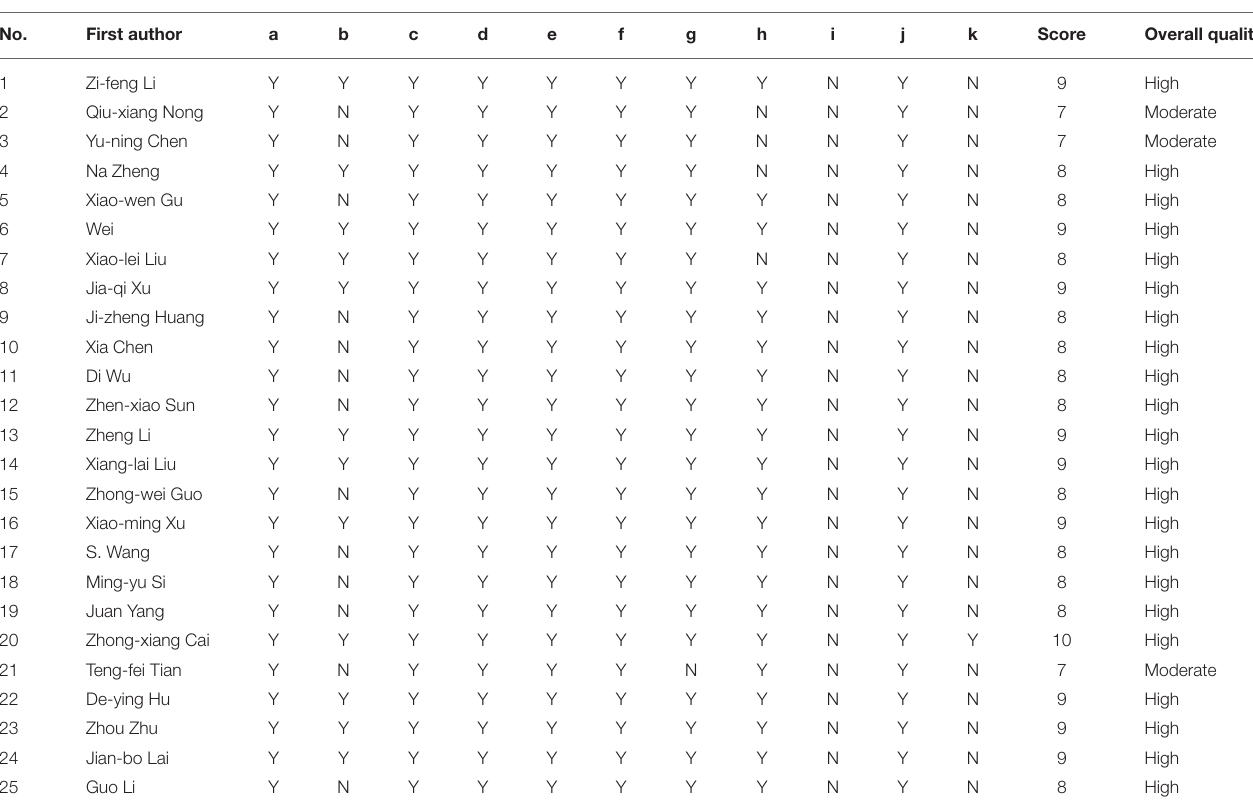
TABLE 2 | Methodological quality assessment of the included studies in this systematic review.